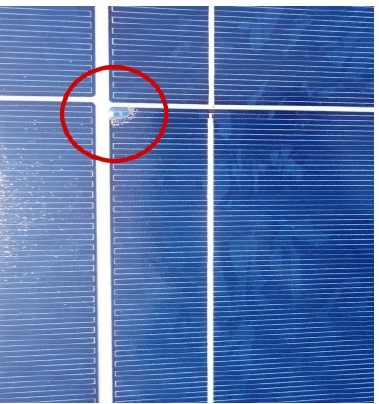
Figure 10. Delamination in the structure of the panel [24].